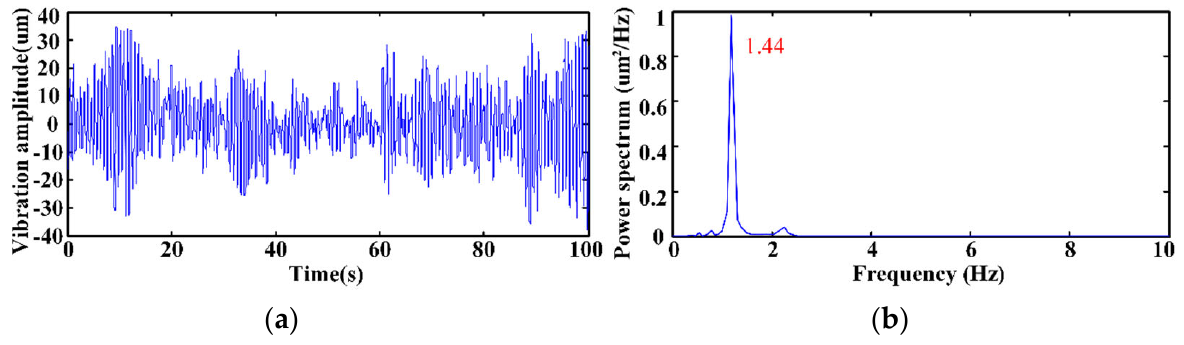
Figure 6. Time history signals and power spectra of B4 measuring point under condition 2. ( a ) Time history signals; ( b ) Normalized power spectra.